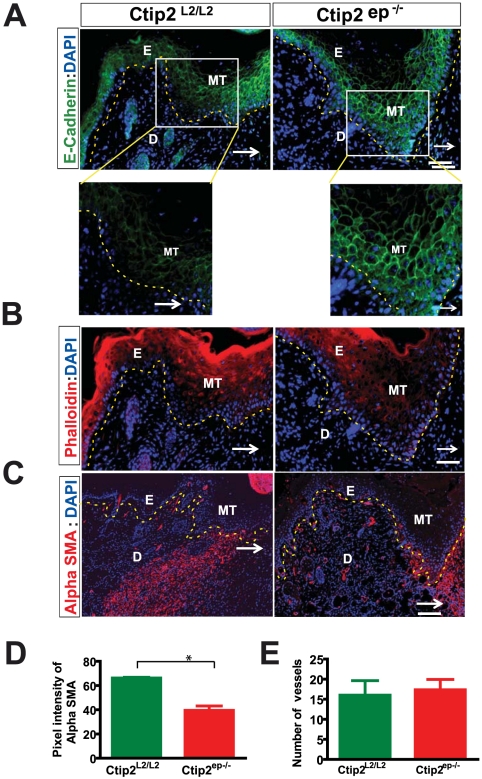
Altered expression of E-cadherin, Phalloidin and alpha SMA in Ctip2ep−/− mutant day 5 skin wounds.(A) Expression of E-Cadherin is down regulated in the Ctip2L2/L2 control basal layer migratory tongue but not in Ctip2ep−/− mutants. The insets are magnified. (B) Expression of Phalloidin (red) is down regulated in the Ctip2L2/L2 control but not in Ctip2ep−/− mutant migratory tongue. (C) Reduced accumulation of myofibroblast (alpha SMA: red) in Ctip2ep−/− mice wounds compared to the wild type mice. (D) Quantification of alpha SMA. Bar graph shows reduced pixel intensities in Ctip2ep−/− compared to the Ctip2L2/L2 control. Data are represented as means ± SD. Significant differences between Ctip2L2/L2 and Ctip2ep−/− (P<0.05). (E) Increased numbers of blood vessels in Day 5 post wounding samples inCtip2L2/L2 compared to Ctip2ep−/− mice but not significant. Values are the mean and SEM (n = 4 mice). MT-migratory tongue; E-epidermis and D- dermis. Arrows point to the directions of the wound. Dotted lines demarcate the epidermis from the dermis. Scale bars: 50 µm (A and B), 100 µm (C).